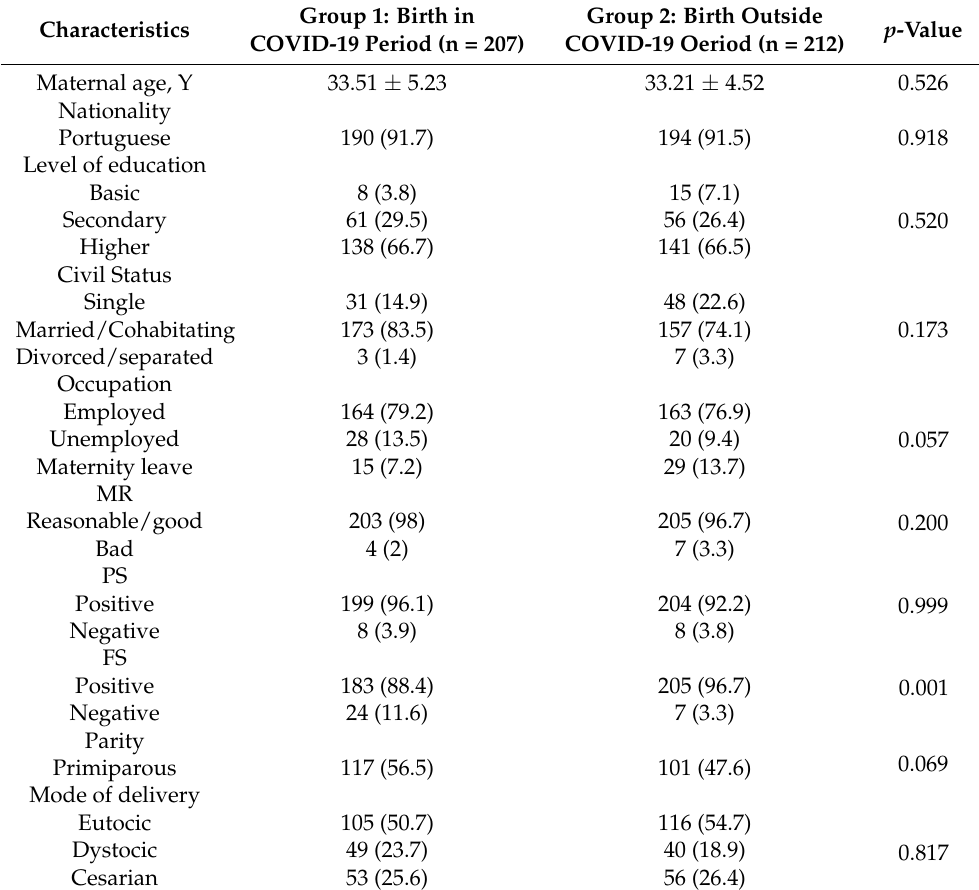
Table 1. Sociodemographic characteristics and psychosocial and clinical features of mothers who gave birth in COVID-19 period (Group 1) and mothers who gave birth outside COVID-19 period (Group